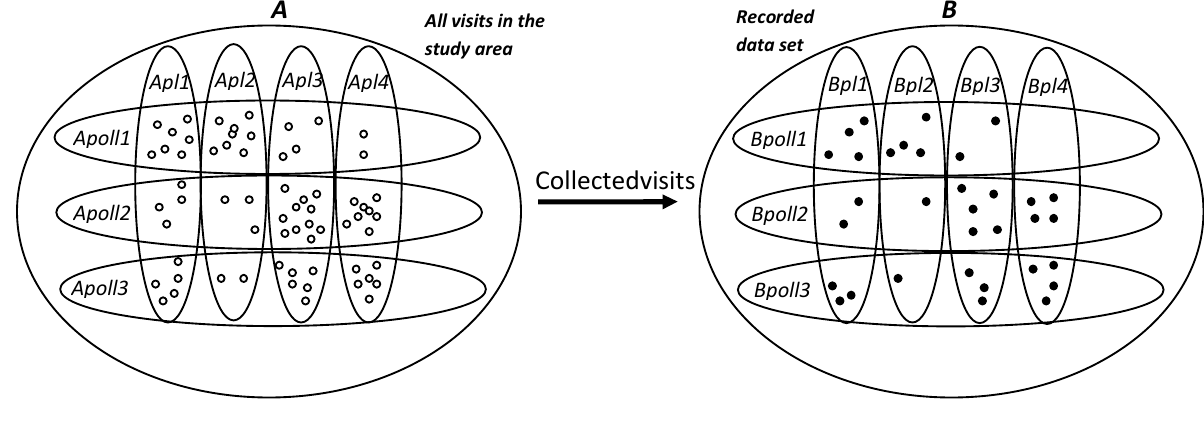
Figure 1. Illustration of the concept model, including three pollinator species and four plant species, with the set of all interactions between pollinator and plant species (A) and a subset of recorded interactions (B). The definition of sets in the model concept follows the definitions in the text, where every single dot ( ) represents is a